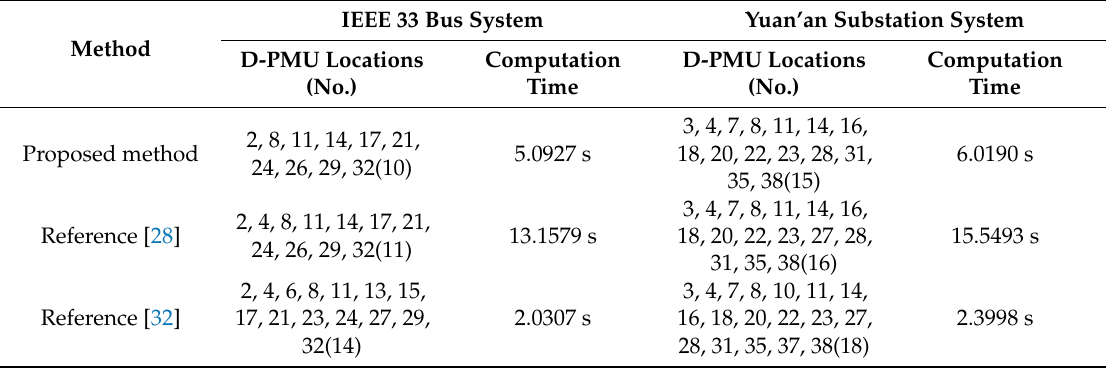
Table 7. Comparison of optimal solutions in the IEEE 33 system and the Yuan’an substation